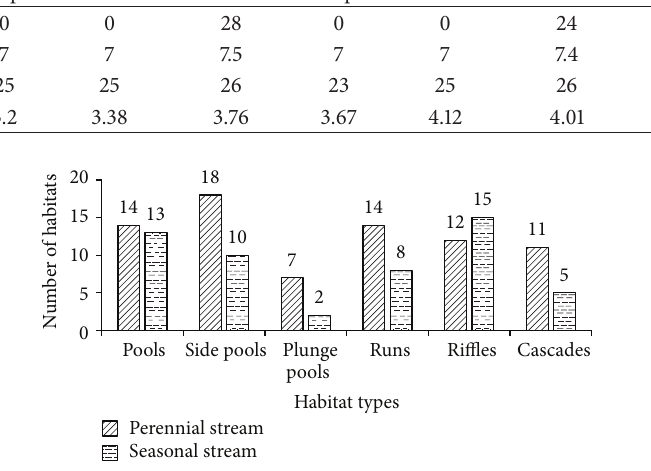
Figure 2: Habitats in the streams.